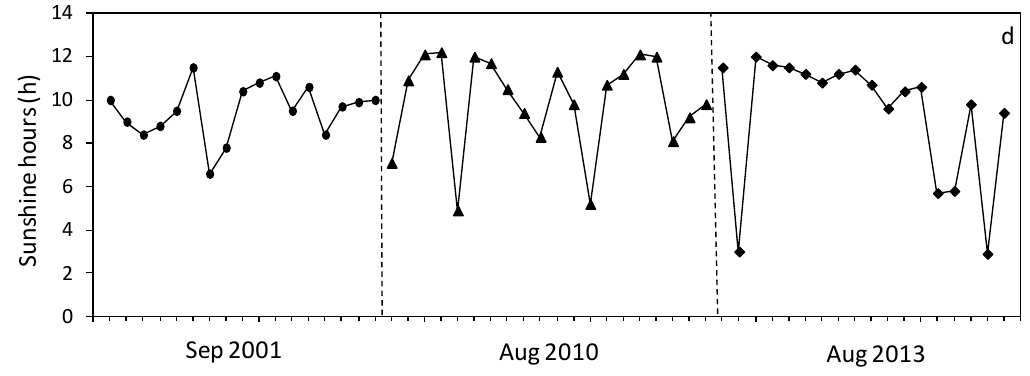
Figure 10. Three examples of daily algal bloom area, wind speed, temperature, and sunshine hours. The blue circles mark the examples where floating bloom area changed because of the wind speed. The red circle shows an example where low winds were not followed by severe